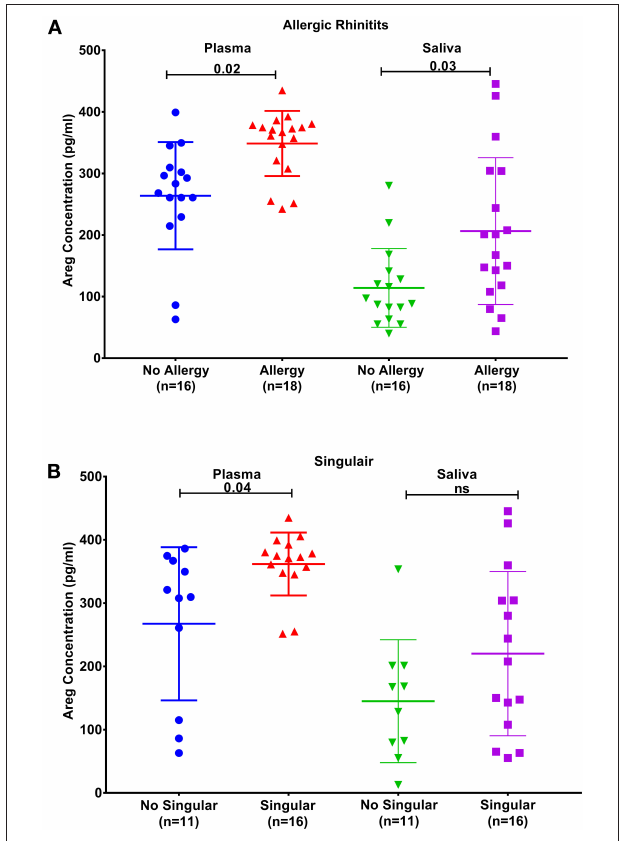
FIGURE 3 | AREG protein levels in plasma and saliva. (A) in asthmatic with allergic rhinitits compared to those who are not and (B) in asthmatics currently on Montelukast sodium (Singulair) compared to those who are not on